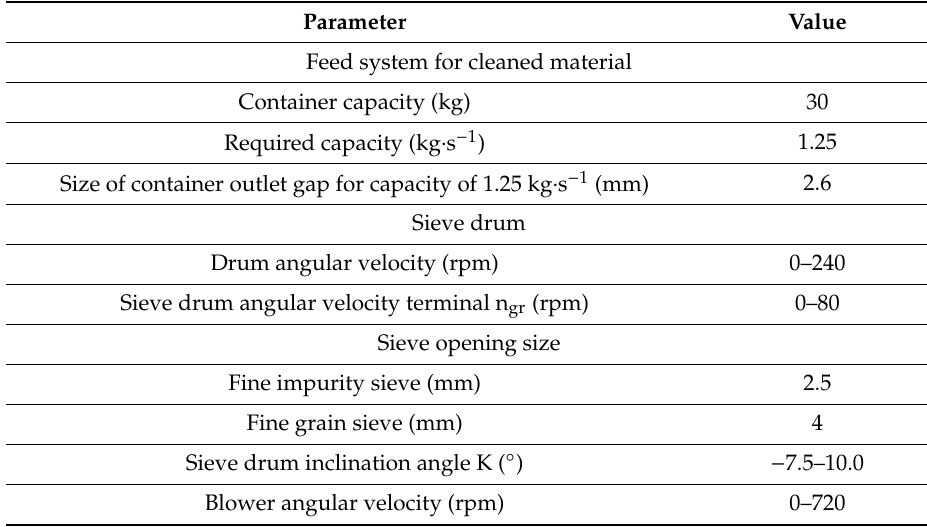
Table 1. Characteristics of technical and working conditions.